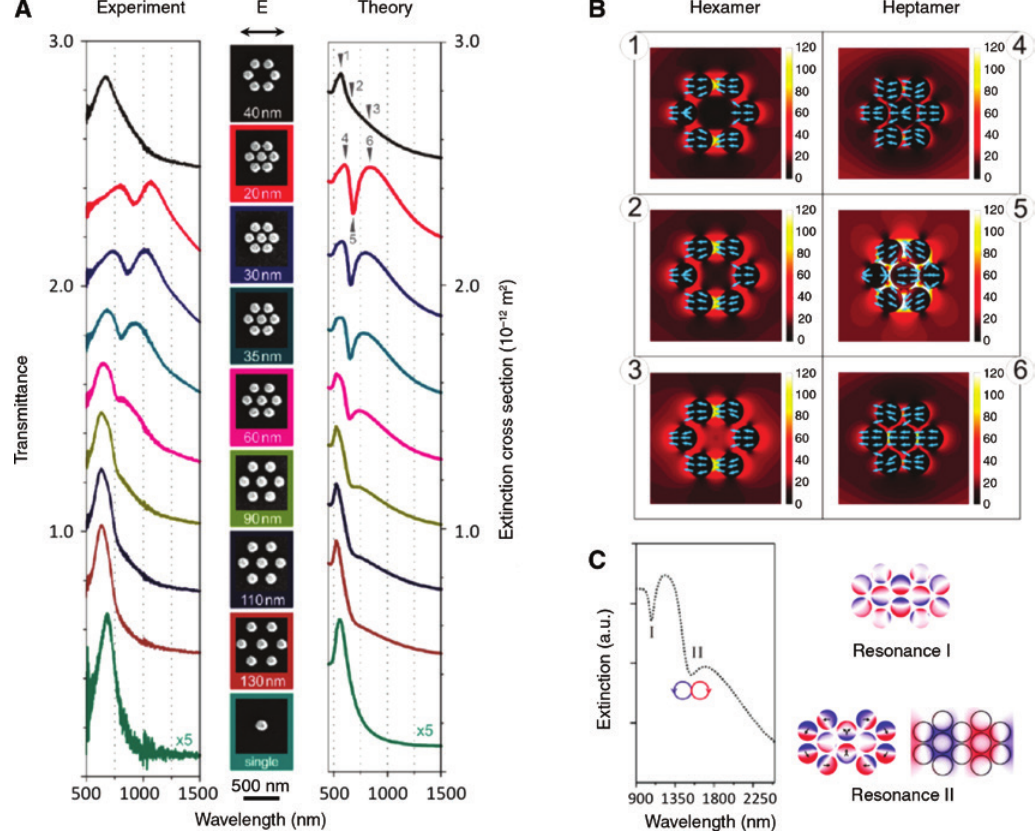
Figure 2: Plasmonic oligomers and displacement currents. (A) Measured and simulated transmittance spectra of an array of heptamers at normal incidence, upon inter-particle gap reduction (brown to red curves). The onset of the Fano resonance is clearly visible for gaps below 90 nm. Both the monomer and the hexamer structures feature a single peak in their corresponding transmittance spectra (aquamarine and black curves, respectively). (B) Near field distribution at the selected wavelengths reported in (A) for both the hexamer and the heptamer. The presence or absence of the Fano resonance is due to the central nanoparticle. The superradiant and subradiant modes that destructively interfere, hence giving rise to the Fano resonance, are characterized by the plasmon on the central nanoparticle oscillating in-phase or in counter phase with respect to the six satellite nanoparticles, respectively. Adapted with permission from Hentschel M, Saliba M, Vogelgesang R, Giessen H, Alivisatos AP, Liu N. Transition from isolated to collective modes in plasmonic oligomers. Nano Lett 2010;10:2721–6 (Ref. [47]). Copyright 2010 American Chemical Society. (C) Simulated extinction spectrum of a naphthalene-like oligomer (left) and charge densities and magnetic field plots at resonances I and II (right). Adapted with permission from Liu N, Mukherjee S, Bao K, et al. Magnetic plasmon formation and propagation in artificial aromatic molecules. Nano Lett 2012;12:364–9 (Ref. [89]). Copyright 2012 American Chemical